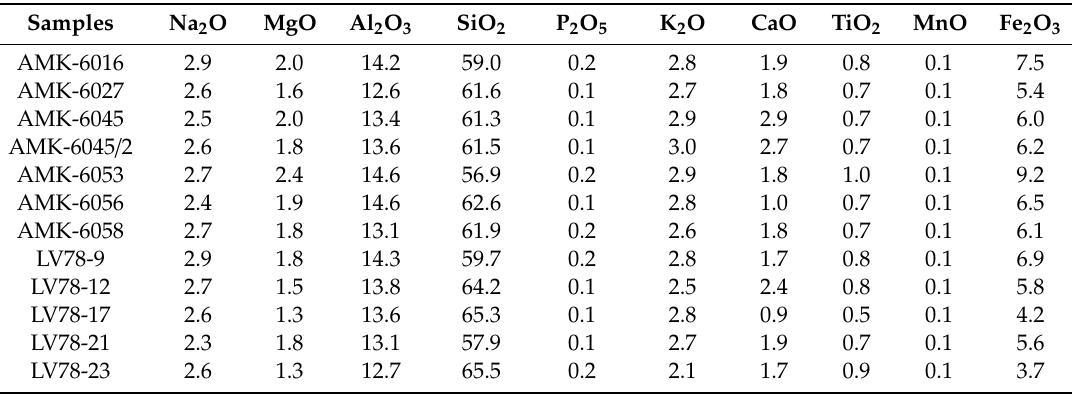
Table 1. Chemical composition of the studied sediment samples.